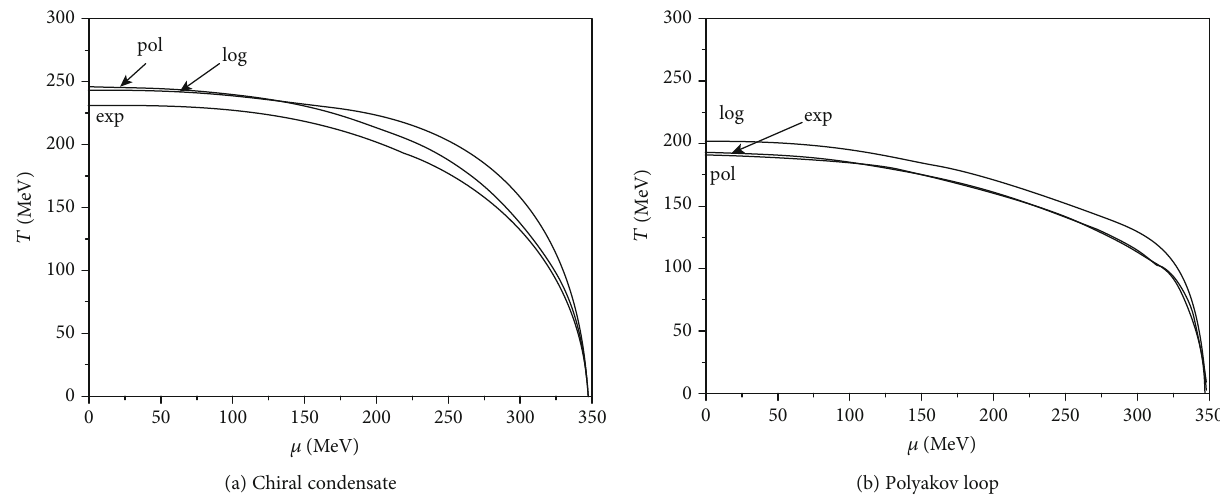
Figure 5: Phase diagram superposition for global